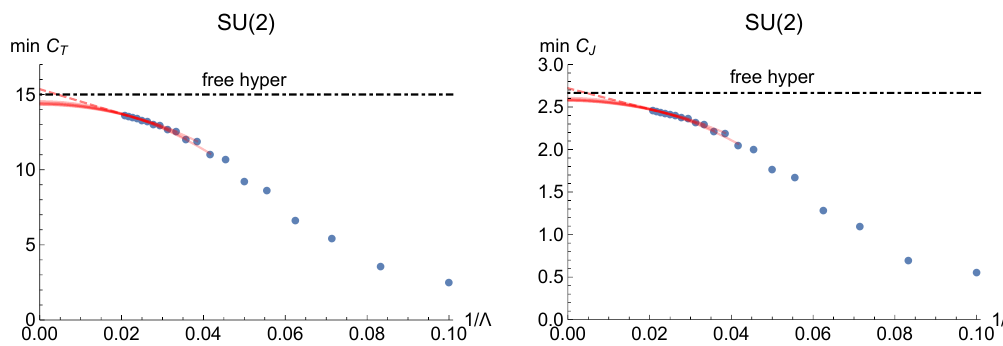
Figure 2. Lower bounds on C T and C J for general (free or interacting) theories with SU(2) (cid:13)avor group and twist gap (cid:1) (cid:0) s (cid:21) 6, at various derivative orders (cid:3) and extrapolated to in(cid:12)nite order using the quadratic ansatz (5.21) (solid) and the linear ansatz (5.22) (dashed). Also shown are the values C T = 15 and C J = 8 for a free hypermultiplet 3